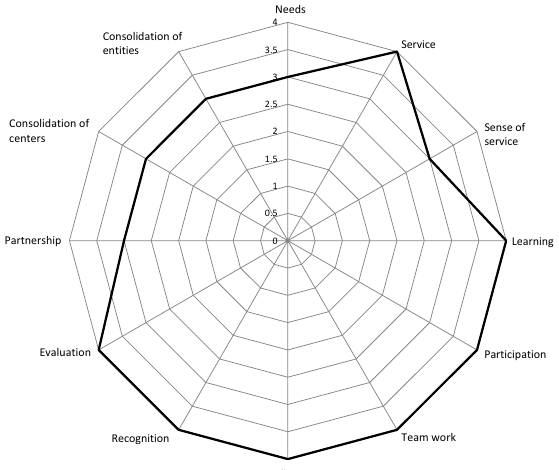
Figure 6. Project assessment.